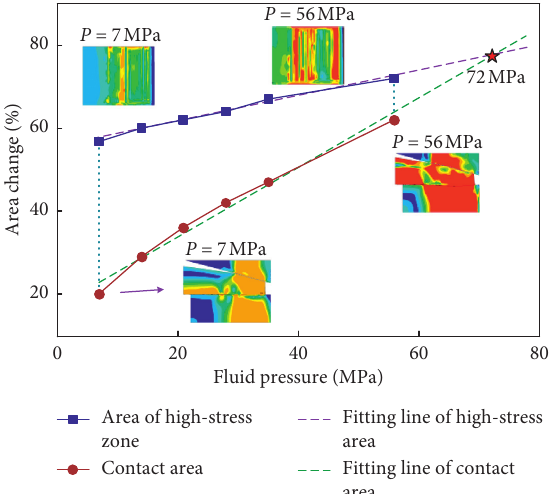
Figure 9: Relationship between the contact area, high-stress zone area, and different fluid